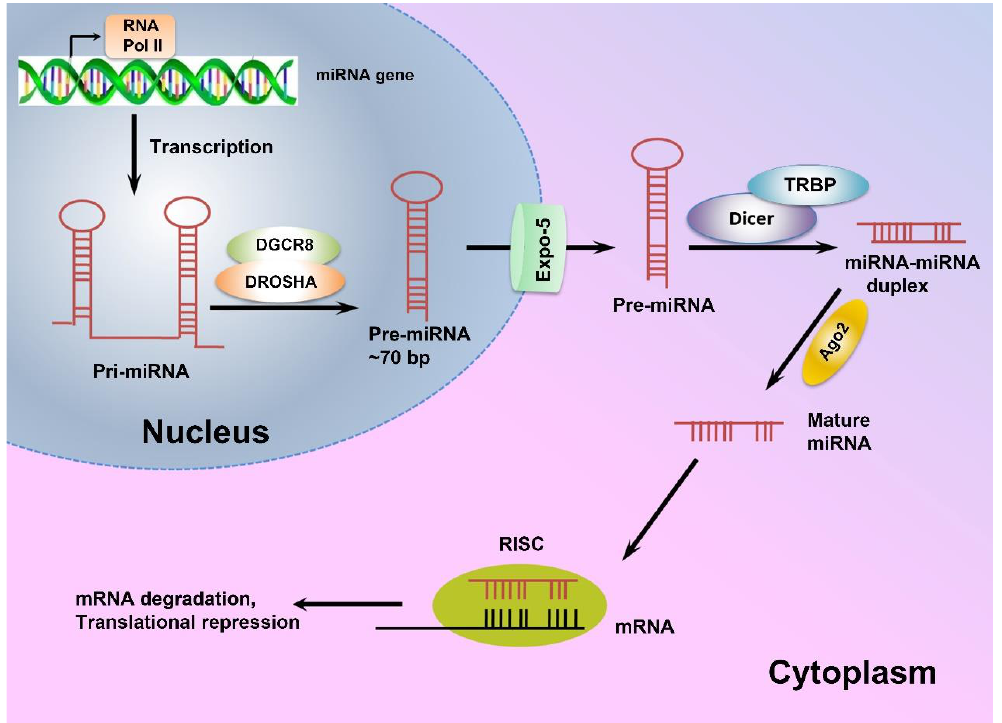
Figure 1. The schematic view of miRNA biogenesis. MicroRNAs are mainly transcribed by RNA polymerase II as long pri-miRNAs, which are then processed in the nucleus by Drosha endonuclease and its cofactor DiGeorge Syndrome Critical Region 8 (DGCR8). Next, exportin-5 transports the resulting pre-miRNA to the cytoplasm where a complex of Dicer enzyme and TAR RNA binding protein (TRBP) creates a double-stranded miRNA which is unwound to a mature single-stranded miRNA. Finally, the single-stranded miRNA is assembled into a miRNA-induced silencing effector complex (RISC), leading to complementary mRNA sequence and regulating gene expression post- translationally